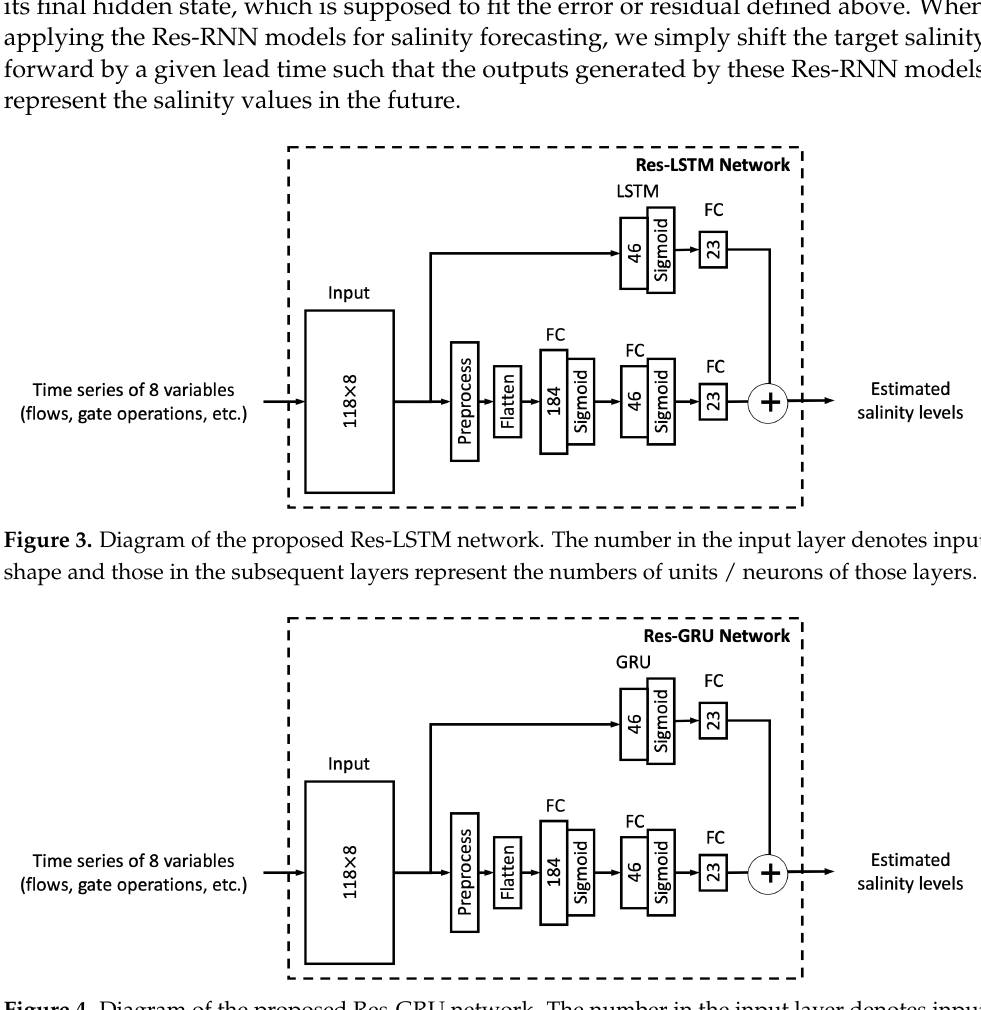
Figure 4. Diagram of the proposed Res-GRU network. The number in the input layer denotes input shape and those in the subsequent layers represent the numbers of units / neurons of those layers.